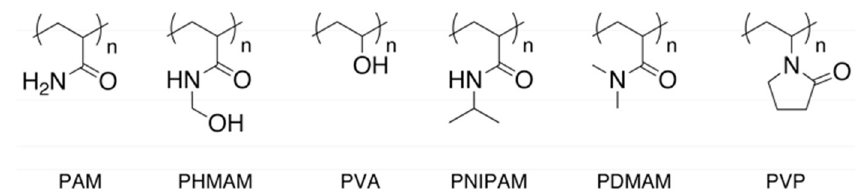
Figure 1 . Structures of examined polymers. Figure 1. Structures of examined polymers.